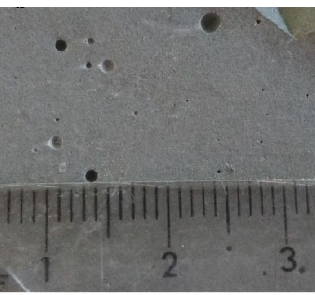
Figure 3. Macroscopic optical image of the CFRC including dispersant [34].